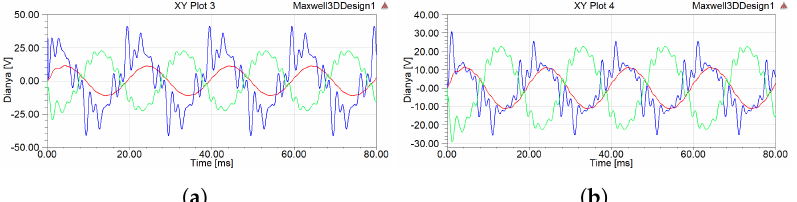
Figure 12. Voltage waveforms from the three windings under working condition 3. ( a ) The left column. ( b ) The right